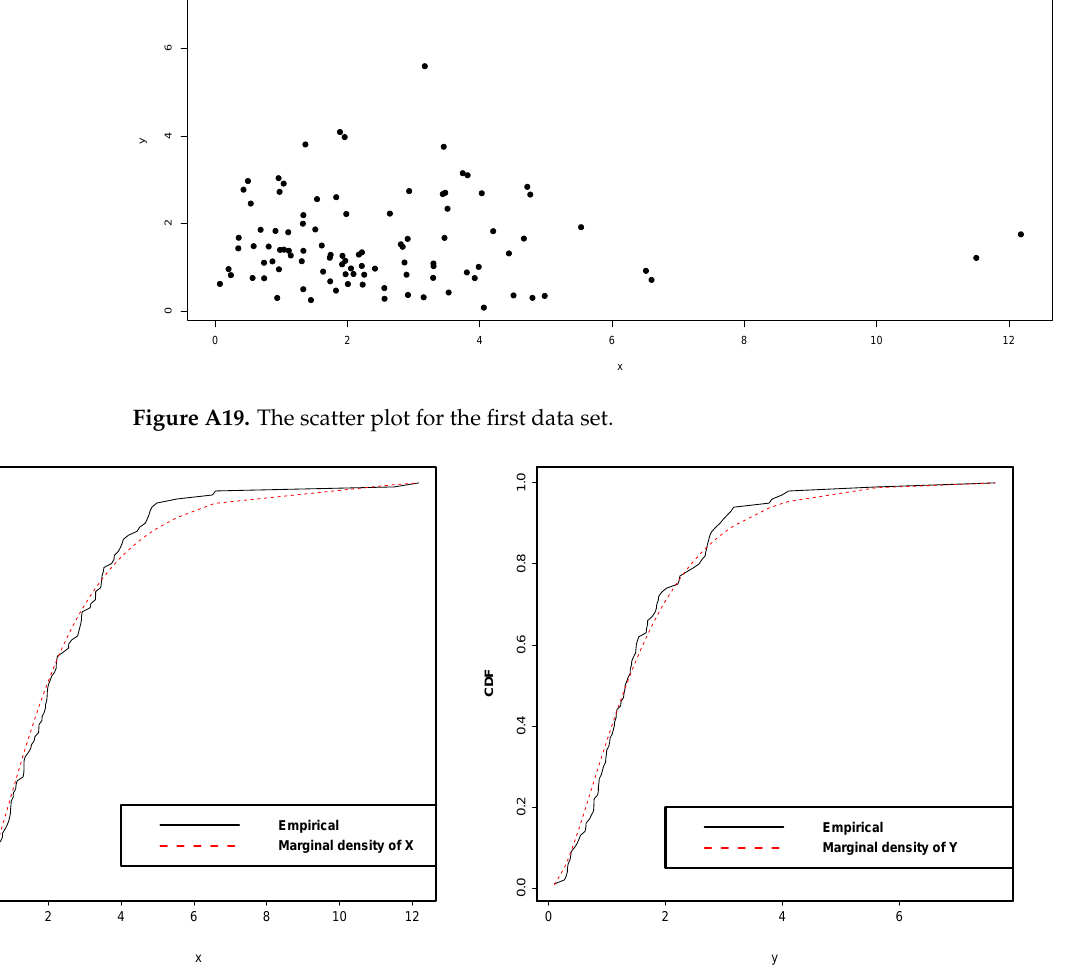
Figure A20. The bivariate KW marginal densities (Equation (1)) plot for the first data